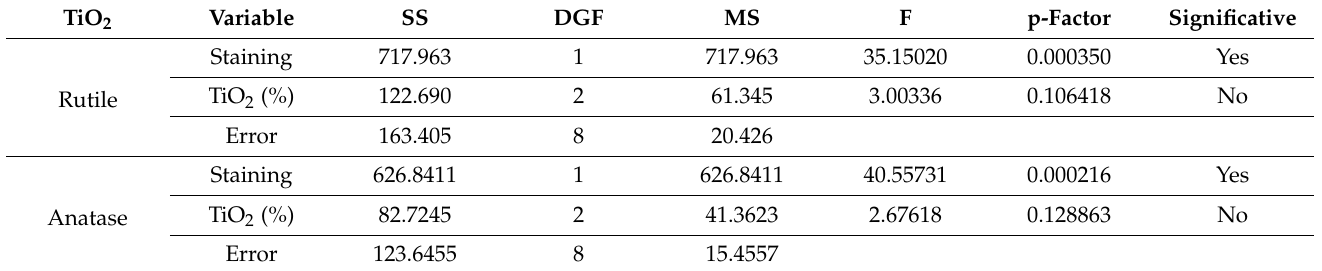
Table 8. Main effects analysis of variance on tiles produced with TiO 2 rutile and anatase, with and without staining by rhodamine B, subjected to UVA